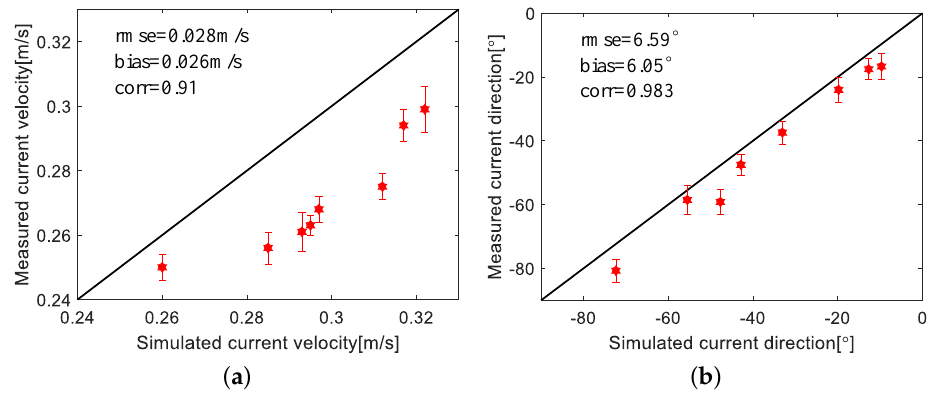
Figure 10. Statistical comparison between the simulated current field and SAR data measured current field. ( a ) Velocity and ( b )